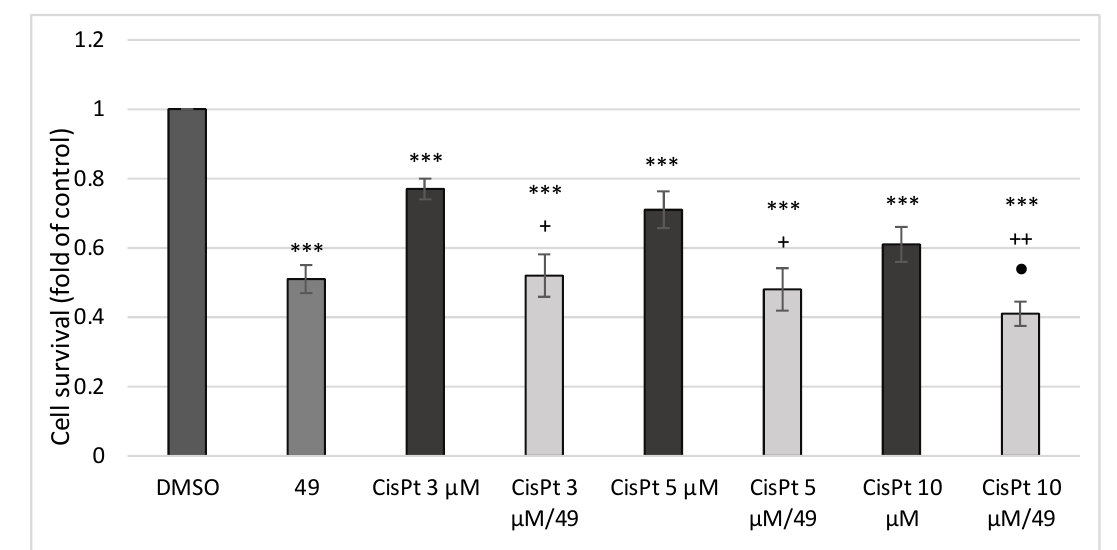
Figure 9. Effect of cis-platin (CisPt) on A549 cell survival either alone or in combination with compound 49 (20 μM). The data show the mean ± SD values of three independent experiments. *** p < 0.001 vs. DMSO, + p < 0.05 vs. CisPt, ++ p < 0.01 vs. CisPt, ● p < 0.05 vs. 49 , ●●